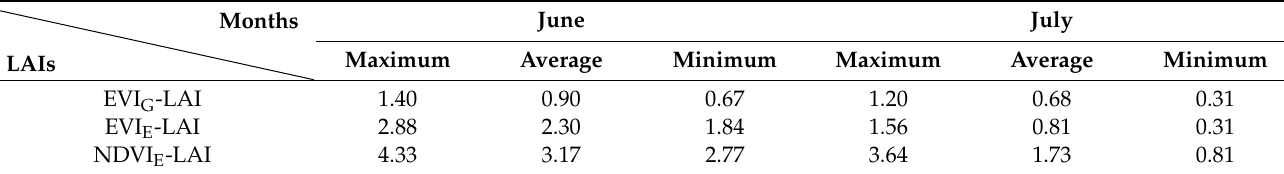
Table 5. Remote sensing LAI values for different sampling months.